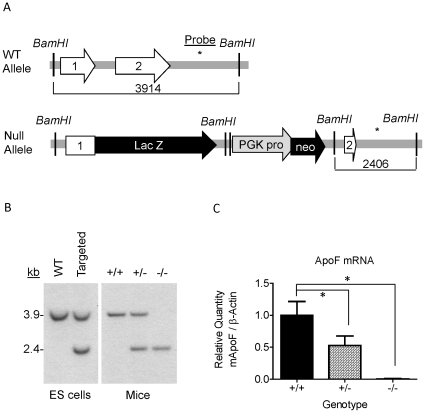
Generation of Apolipoprotein F Deficient Mice.
A. Schematic diagram (not to scale) showing the wild type and deleted ApoF alleles. Features are depicted as follows: Exons- white arrows, Beta galactosidase reporter gene- “LacZ” black arrow, PGK promoter- grey arrow, Neomycin resistance gene- “Neo” black arrow, BamHI restriction sites- vertical lines, and the location of Southern Blotting probe- asterisk. B. Southern blot confirming successful targeting and genomic location of null allele: WT allele yields a 3.9 kb band, while the Null allele is 2.4 kb. The left panel contains ES cell DNA, while the right panel depicts livers from the mice. C. Real Time RT-PCR data on ApoF mRNA in the livers of female wild type (+/+), heterozygous (+/−), and homozygous (−/−) ApoF deficient mice.